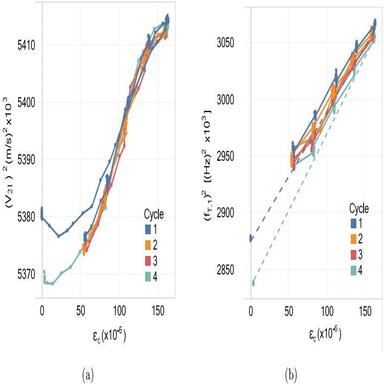
(a) Square of S-wave speed 21 with respect to axial compressive strain. (b) Square of the fundamental torsional frequency of vibration, ( ,1 ) 2 , with respect to compressive strain, where dashed lines indicate loading-increasing stage of cycle 1 and unloading of cycle 4.